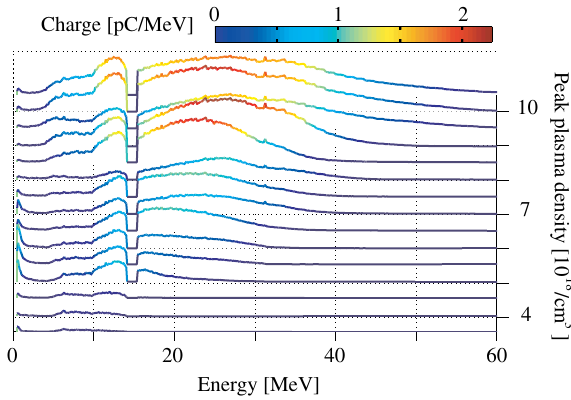
FIG. 9. Electron beam spectra as a function of the peak plasma density. Each spectrum is an average of eight shots. The dip at around 17 MeV is due to the gap in the electron spectrometer